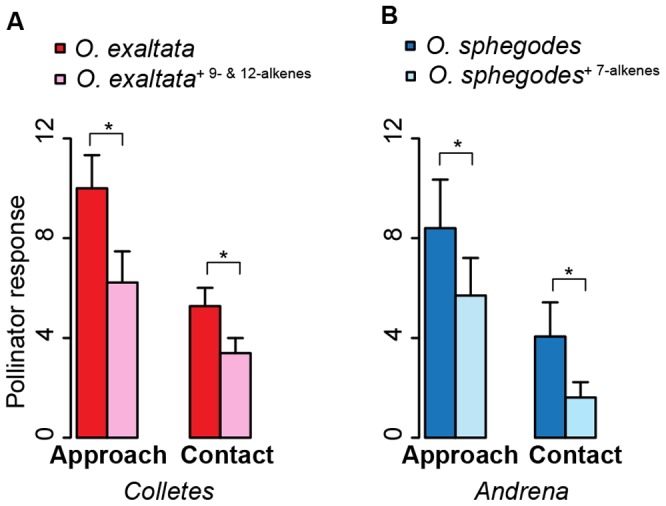
Effects of alkenes with different double-bond position on pollinator behavior.(A) Addition of 9- and 12- alkenes (associated with SAD1/2) onto O. exaltata flowers reduced its pollinator (C. cunicularius) response (N = 18). Red bar, control O. exaltata; pinkish bar, scent manipulated O. exaltata. (B) Adding 7-alkenes (associated with SAD5/6) into O. sphegodes floral scent extract reduced its pollinator (A. nigroaenea) response (N = 17). Blue bar, control floral scent of O. sphegodes; light blue bar, manipulated floral scent of O. sphegodes. Y-axis refers to number of counts. Asterisks indicate statistical significance (pairwise Mann-Whitney U test): *, p<0.05.